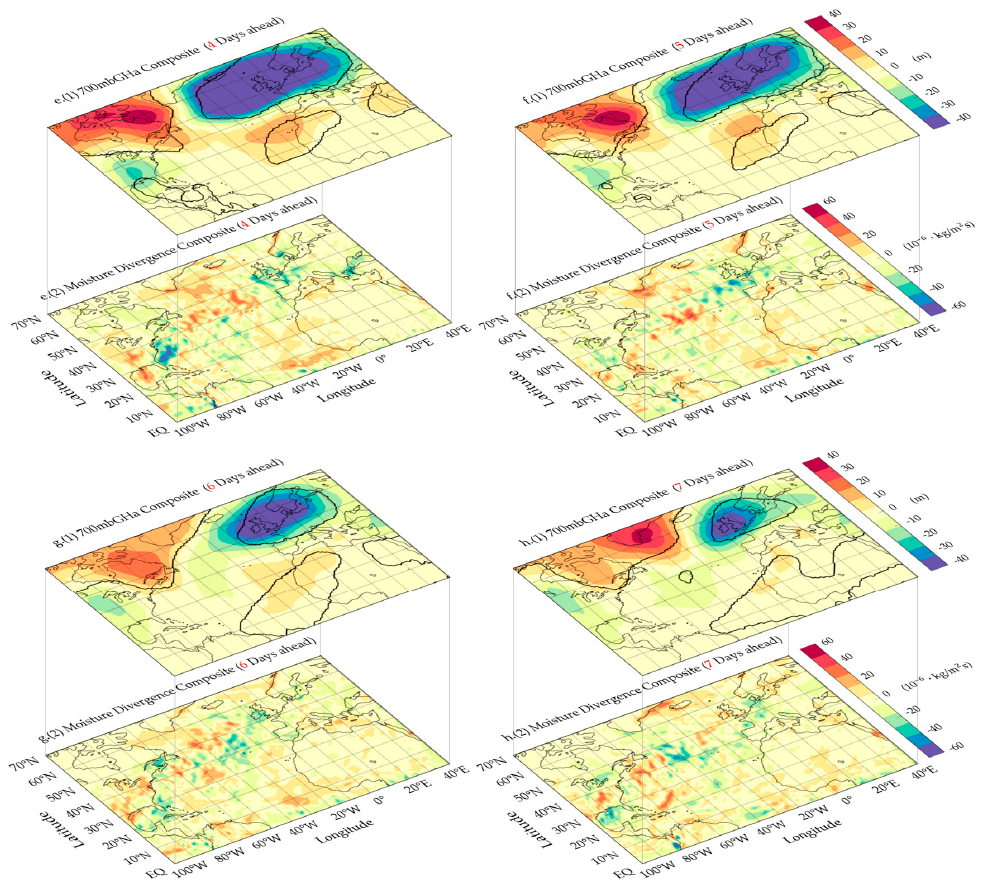
Figure 10. The evolutions of the associated anomalous ( 1 ) atmospheric circulation and ( 2 ) moisture flux during the top 5% extreme precipitation periods using the 700 GHa and VIMFa composites for the Loire river basin from 7 days ahead ( h ) to the extreme precipitation days ( a ). The regions with statistical significant values at the 95% level are circled by the thick black lines.